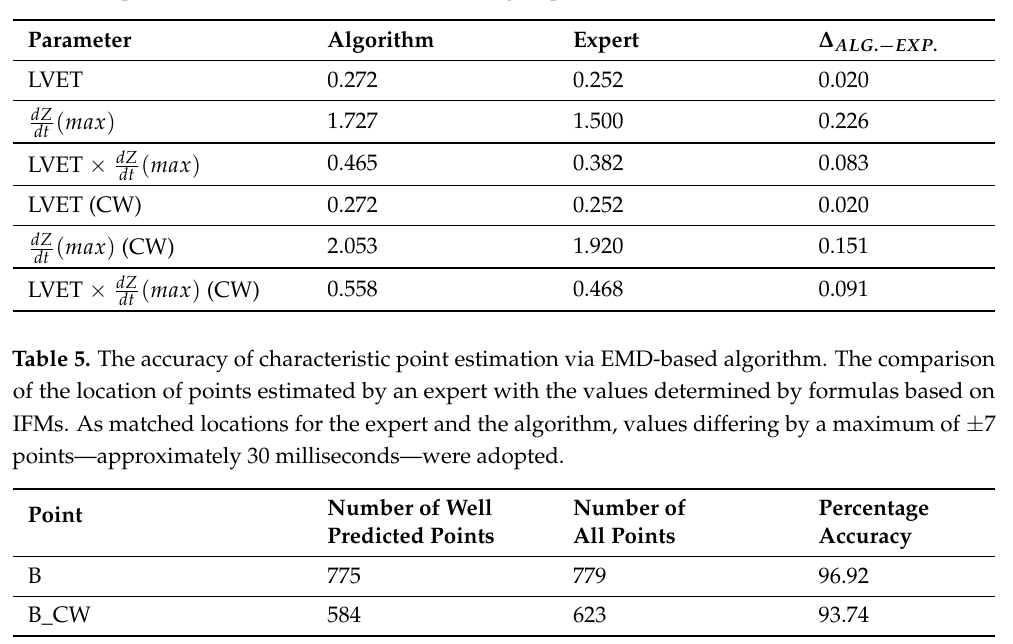
Figure 10. The box-plots comparison of hemodynamic parameters calculated by the algorithm and indicated by an expert. Table 4. The median values of hemodynamic parameters estimated by the algorithm and an expert, and the respective differences between those two groups.